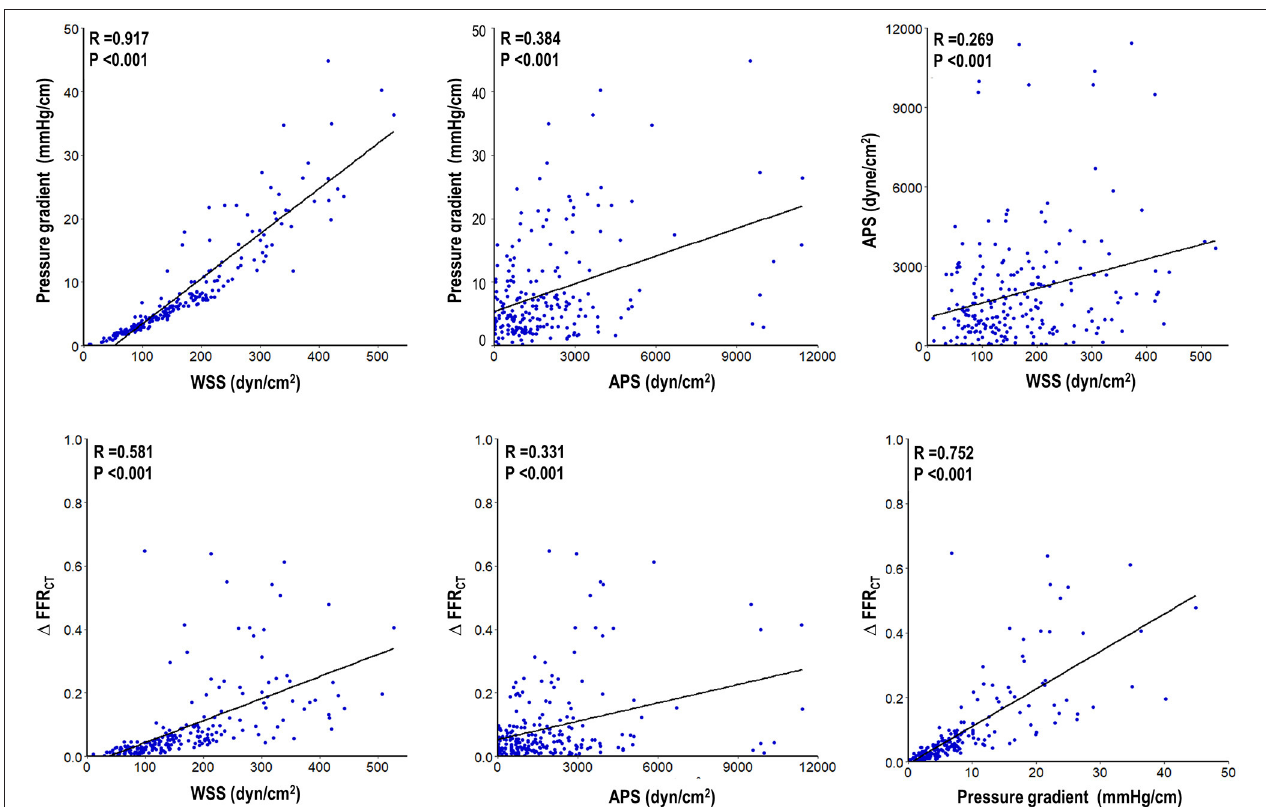
FIGURE 2 | Association among local hemodynamic parameters. Correlation among WSS, APS, PG, and 1 FFR CT is presented. All local hemodynamic parameters were significantly correlated with each other. APS, axial plaque stress; FFR CT , coronary computed tomographic angiography-derived fractional flow reserve; WSS, wall shear